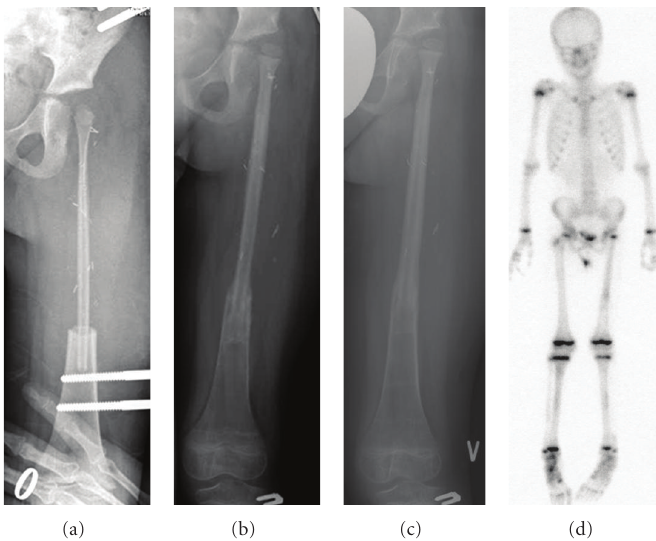
Figure 3: Resection of the proximal part of the femur because of Ewing’s sarcoma and reconstruction with a vascularized fibula graft including the proximal epiphysis (patient 2). X-rays taken 2 weeks postoperatively (a), with follow-up after 7 months when weight-bearing was started (b), after 12 months when full weight-bearing had been allowed for 3 months (c), and finally a bone scan performed 12 months postoperatively (d).